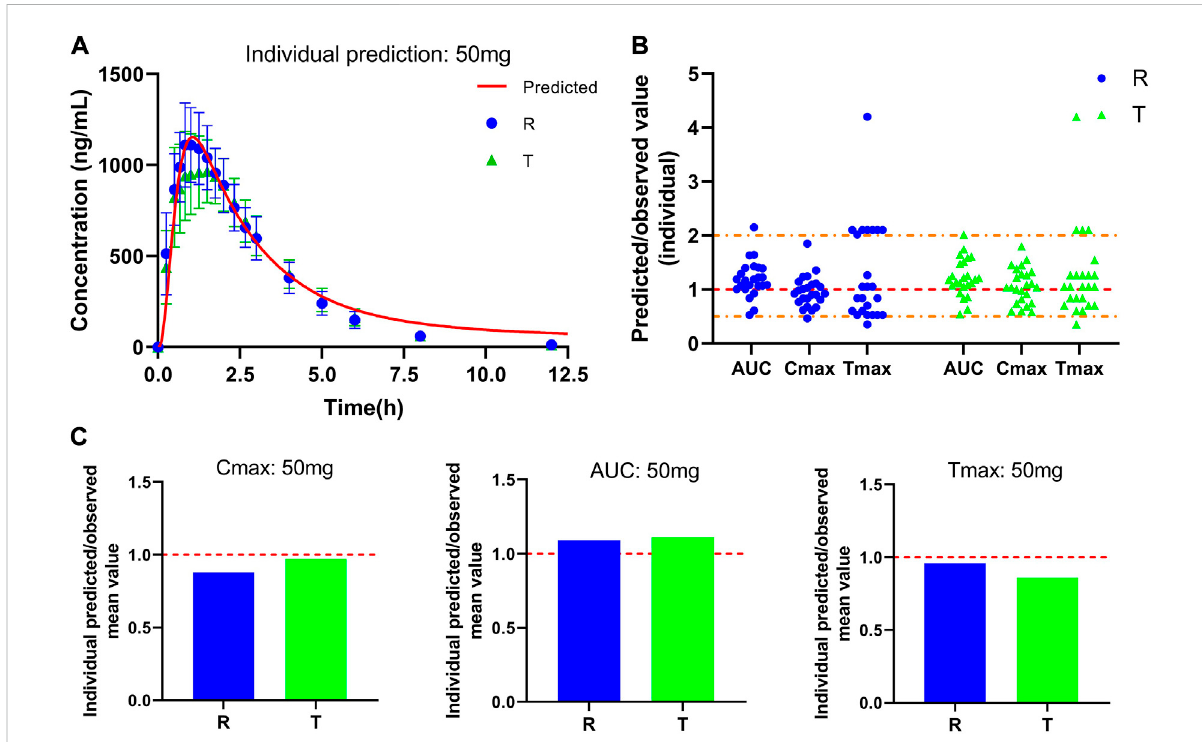
FIGURE 3 Predictedandobservedplasmaconcentration-timecurveandpharmacokineticparametersafterasingleoraldoseof50 mgPTU. (A) Predicted plasma concentration-time curve and observed value, red solid line: predicted individual curve, blue circles: observed value (R) and standard deviation, green triangles: observed value (T) and standard deviation. (B) Predicted/observed value (individual), yellow dashed line: 0.5 and 2-fold error line, red dashed line: 1-fold error line. (C) Individual Predicted/observed mean value, red dashed line: 1-fold error line. Data are presented as mean ± standard